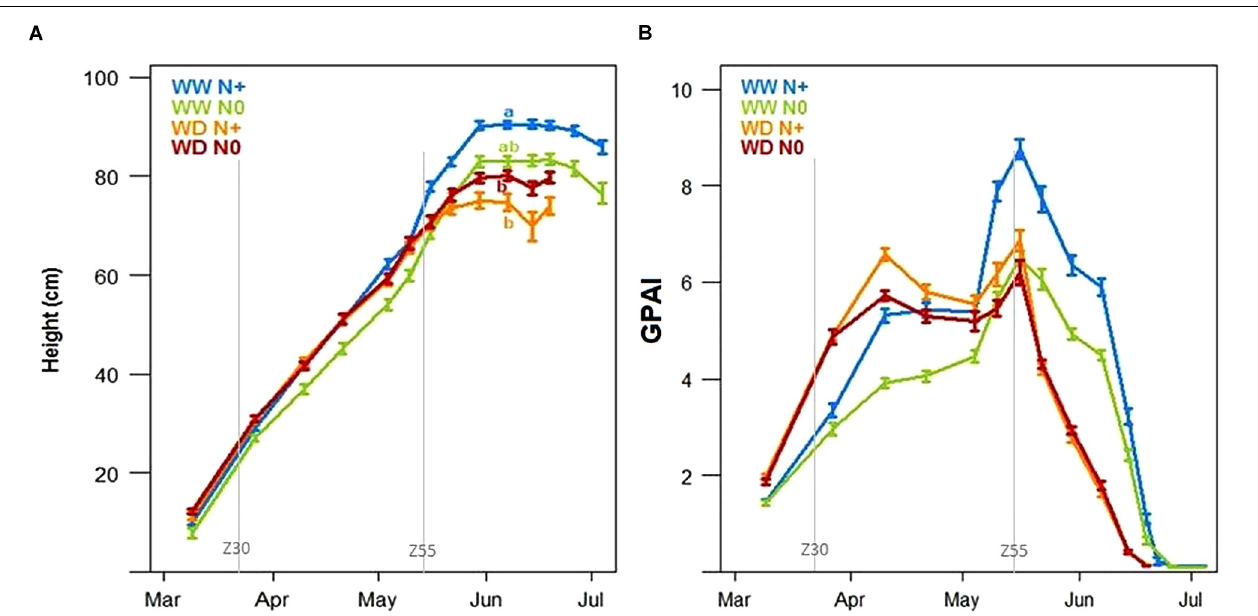
FIGURE 11 | Mean of wheat height (cm) (A) and green plant area index (B) during the growing season under well-watered conditions with and without nitrogen input (WW N+ and WW N0) and water deficient conditions with and without nitrogen input (WD N+ and WD N0, N = 44, ± SE). Letters represent significant height differences on 30th May (Tukey post hoc test, p <